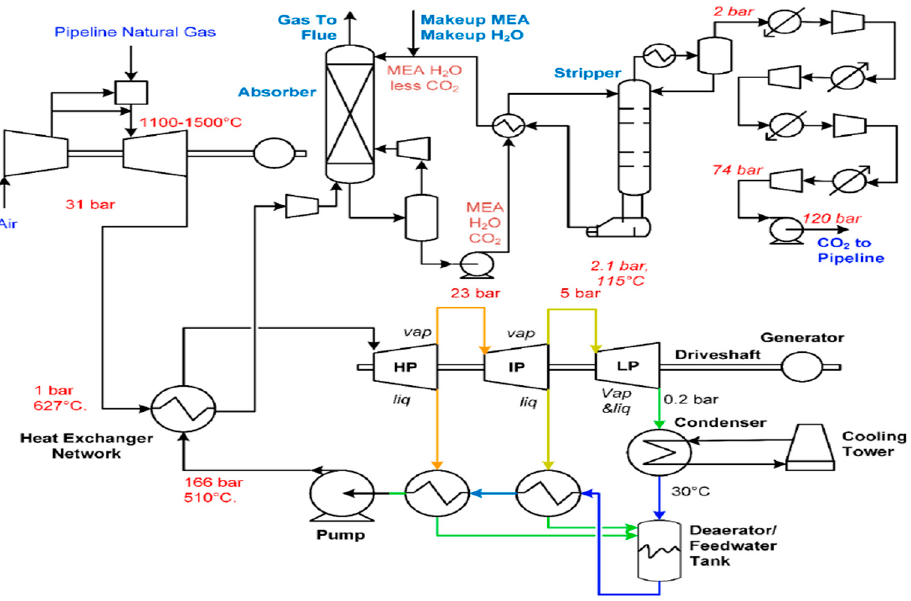
Figure 5. Layout of a post combustion carbon capture power plant operating with natural gas as the fuel fuel [33].